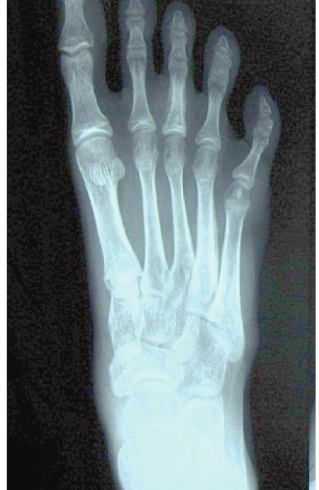
Figure 1: Radiograph of left hand (lateral view), showing corti- cal thickening and expansion of third metacarpal predominantly involving diaphysis with subperiosteal reaction.